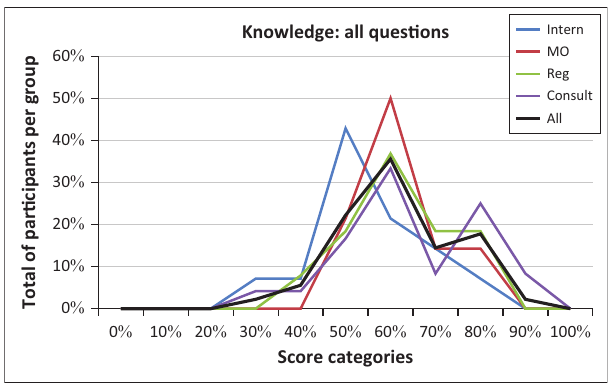
FIGURE 2: Comparison of participants’ knowledge of ototoxicity as depicted from all questions across positions.